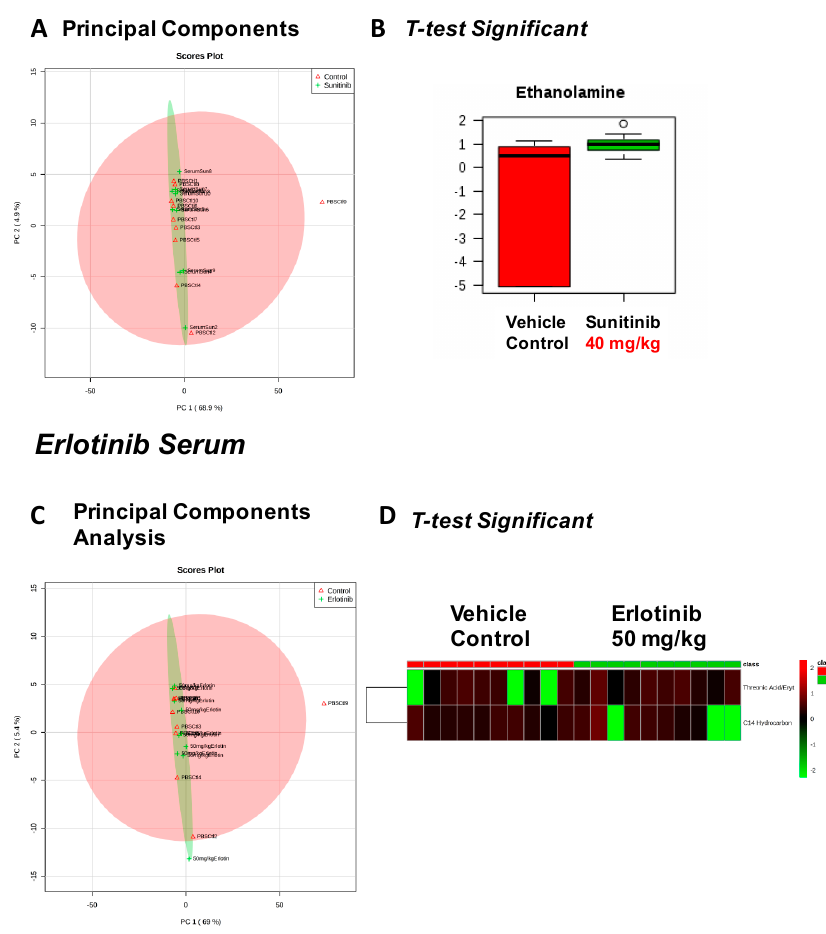
Figure 5. Significant serum metabolites identified after 2 weeks of tyrosine kinase inhibitor (or vehicle control) treatment. PCA (principal components analysis) of serum metabolites from sunitinib-treated mice ( A ). t -test significant metabolites identified in serum from sunitinib-treated mice ( B ). PCA (principal components analysis) of serum metabolites from erlotinib-treated mice ( C ). t -test significant metabolites identified in serum from erlotinib-treated mice ( D ). N = 10/group